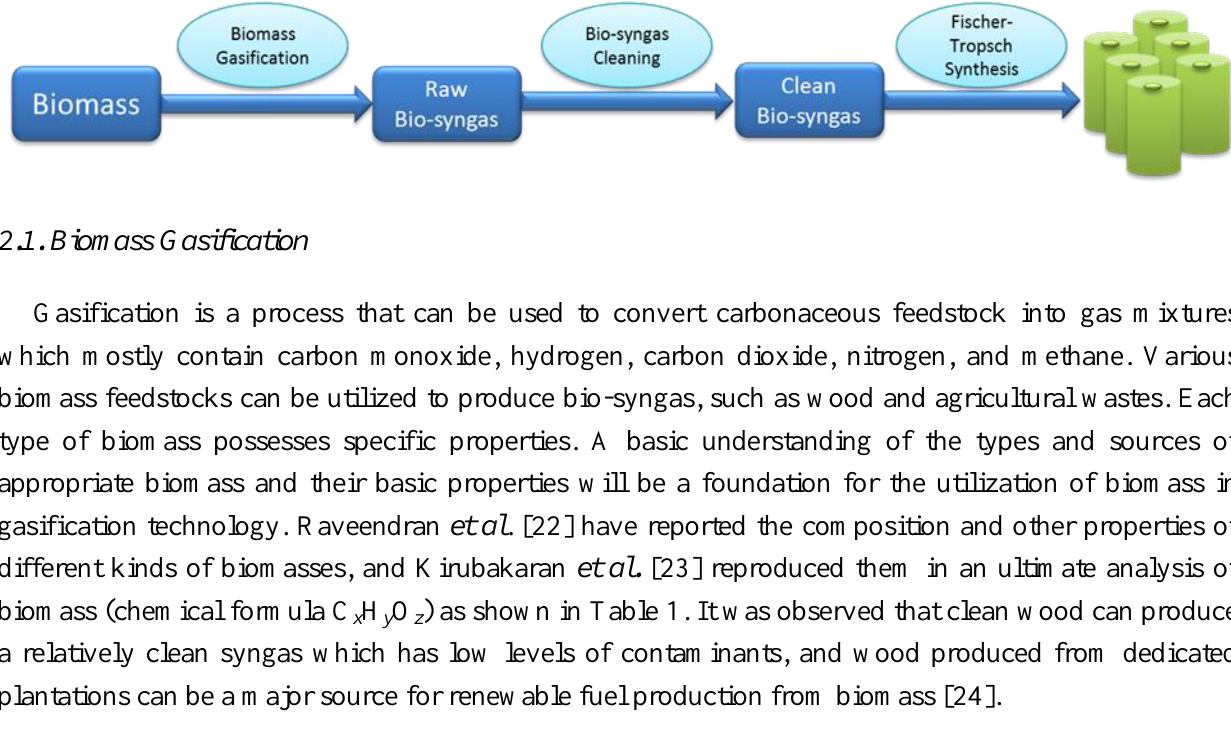
Figure 2. Flow sheet of the Biomass to Liquid via Fischer–Tropsch Synthesis (BTL-FT)